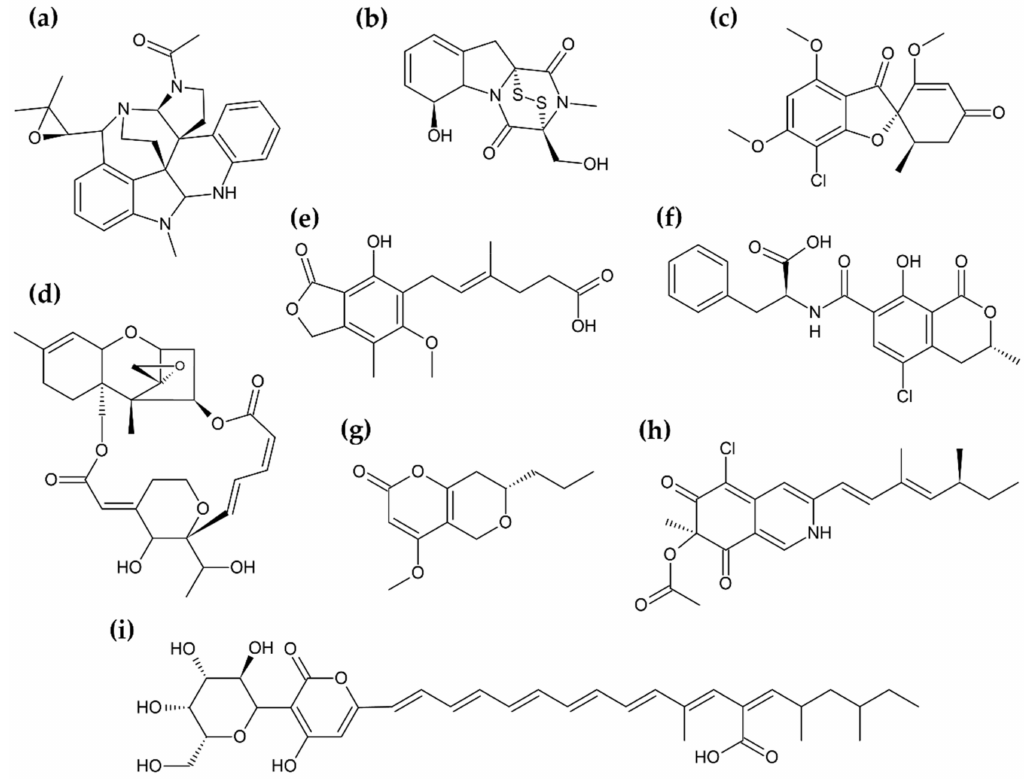
Figure 2. The structural diversity of SMs reported in fungal exudates. ( a ) communesin A; ( b ) gliotoxin; ( c ) griseofulvin; ( d ) macrocyclic trichothecene (satratoxin H); ( e ) mycophenolic acid; ( f ) ochratoxin A; ( g ) phomopsinone A; ( h ) sclerotio- ramine; ( i ) epipyrone